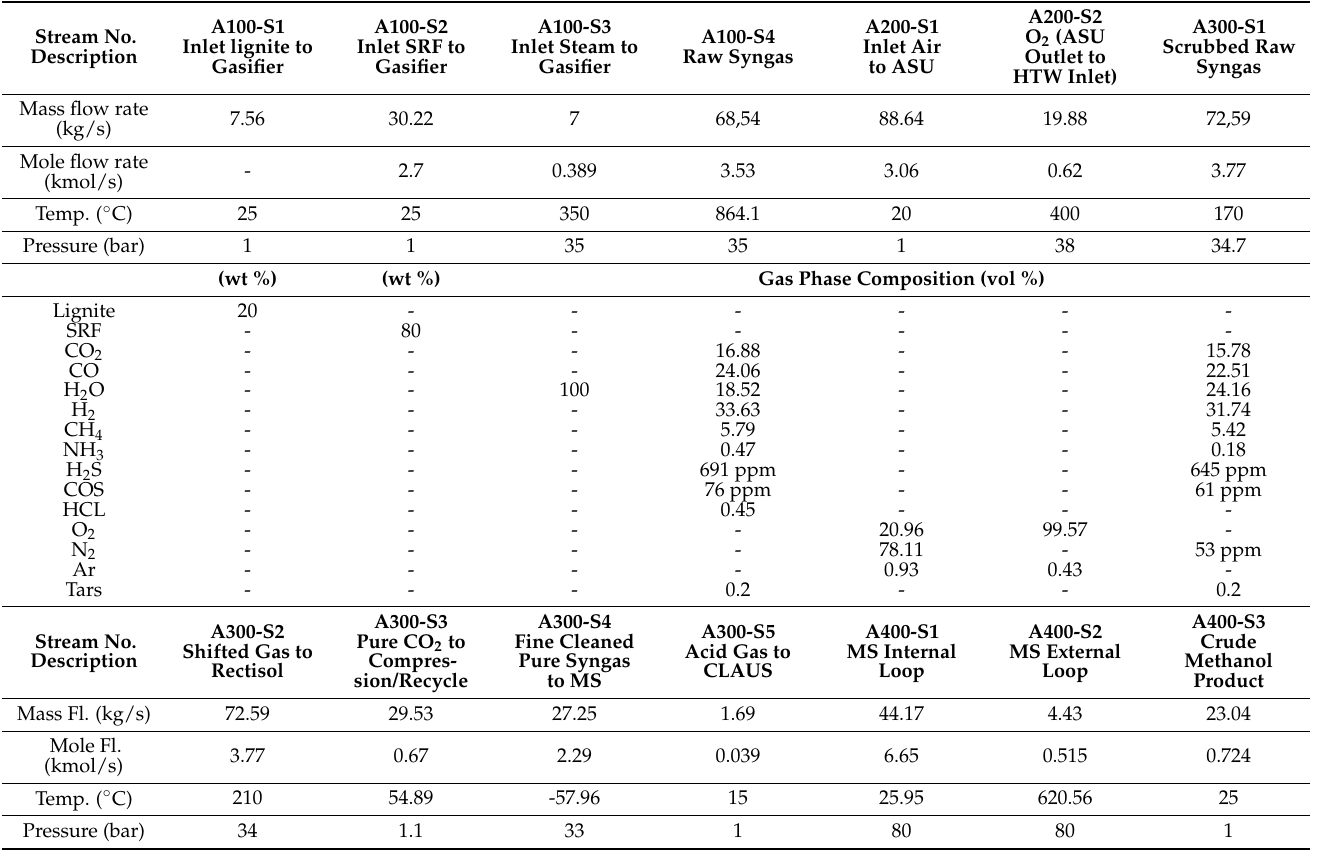
Table A2. Main stream results of the plant process for case 3 (20% LEG–80%